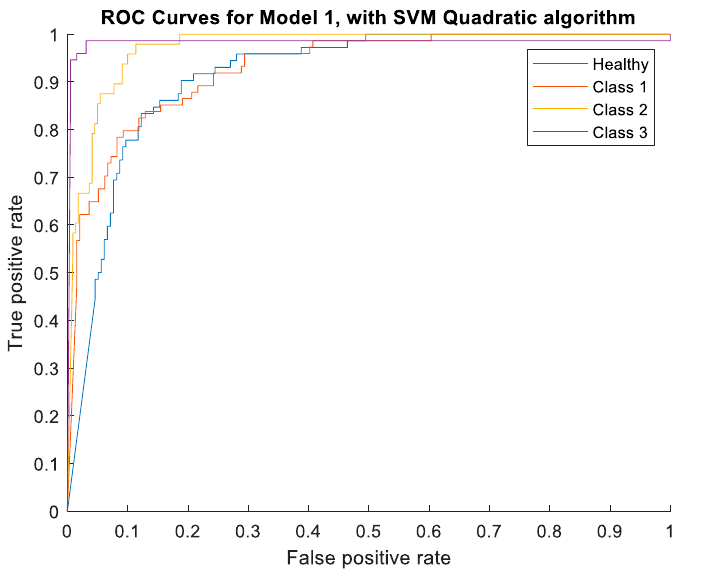
Figure 5. ROC Curves for Model 1, with SVM Quadratic algorithm.